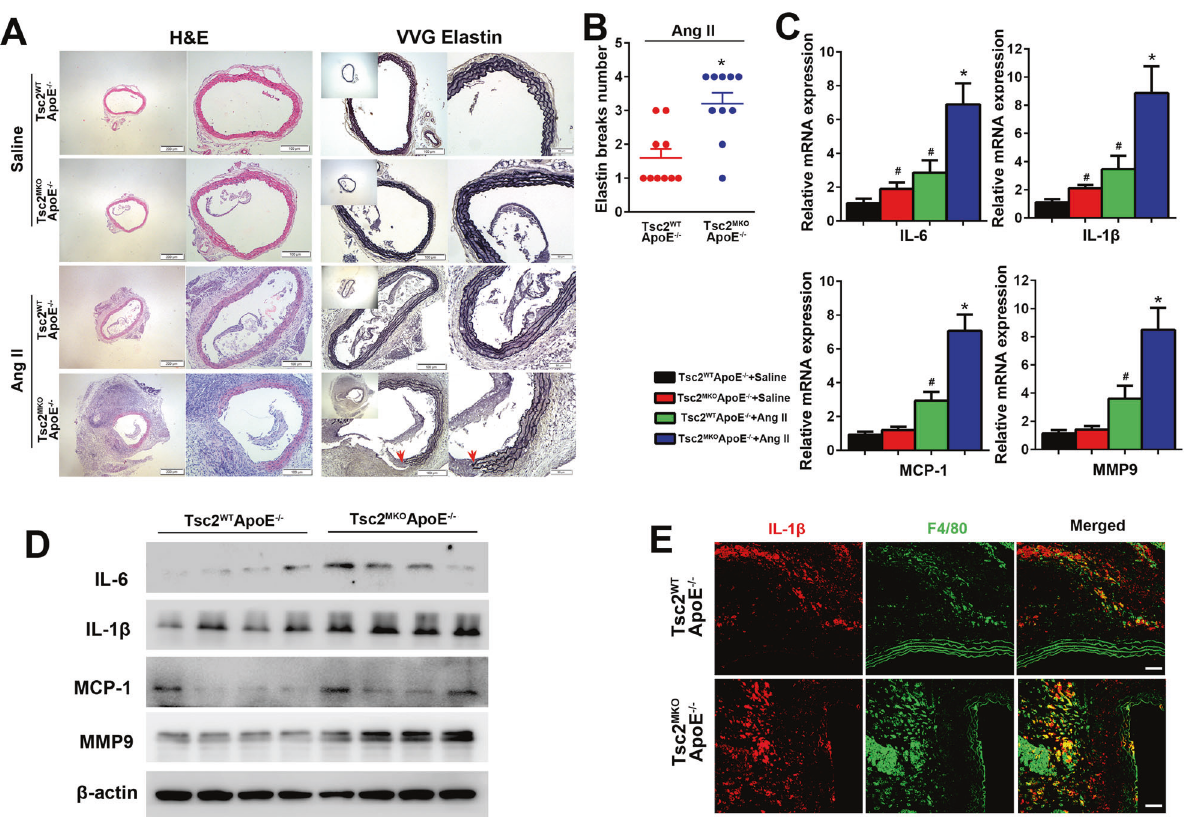
Fig. 2 Myeloid-speci fi c deletion of Tsc2 exacerbates aortic elastic fi ber degradation and vascular in fl ammation in AngII infused mice. A Representative hematoxylin and eosin (H&E) and Verhoeff-van Gieson (VVG) staining of the abdominal aortic sections in Tsc2 WT ApoE – / – and Tsc2 MKO ApoE – / – mice with or without AngII infusion. Red arrow indicated elastin break. B Quantifcation of elastin breaks per section in aortic cross sections harvested from AngII infused mice ( n = 10). C Quanti fi cation of IL-6, IL1- β , MCP-1, and Mmp9 mRNA expression in abdominal aorta harvested from Tsc2 WT ApoE – / – and Tsc2 MKO ApoE – / – mice with or without AngII infusion for 28 d ( n = 5). D Western blot analysis of IL-6, IL1- β , MCP-1, and Mmp9 expression in abdominal aorta harvested from AngII-infused Tsc2 WT ApoE – / – and Tsc2 MKO ApoE – / – mice ( n = 4). E Representative images of IL1- β expression by F4/80 + macrophages in abdominal aortic tissues from AngII-infused Tsc2 MKO ApoE – / – and Tsc2 WT ApoE – / – mice ( n = 5). * P < 0.05, vs. Tsc2 WT ApoE – / – mice infused with AngII. # P < 0.05, vs . Tsc2 WT ApoE – / – mice infused with